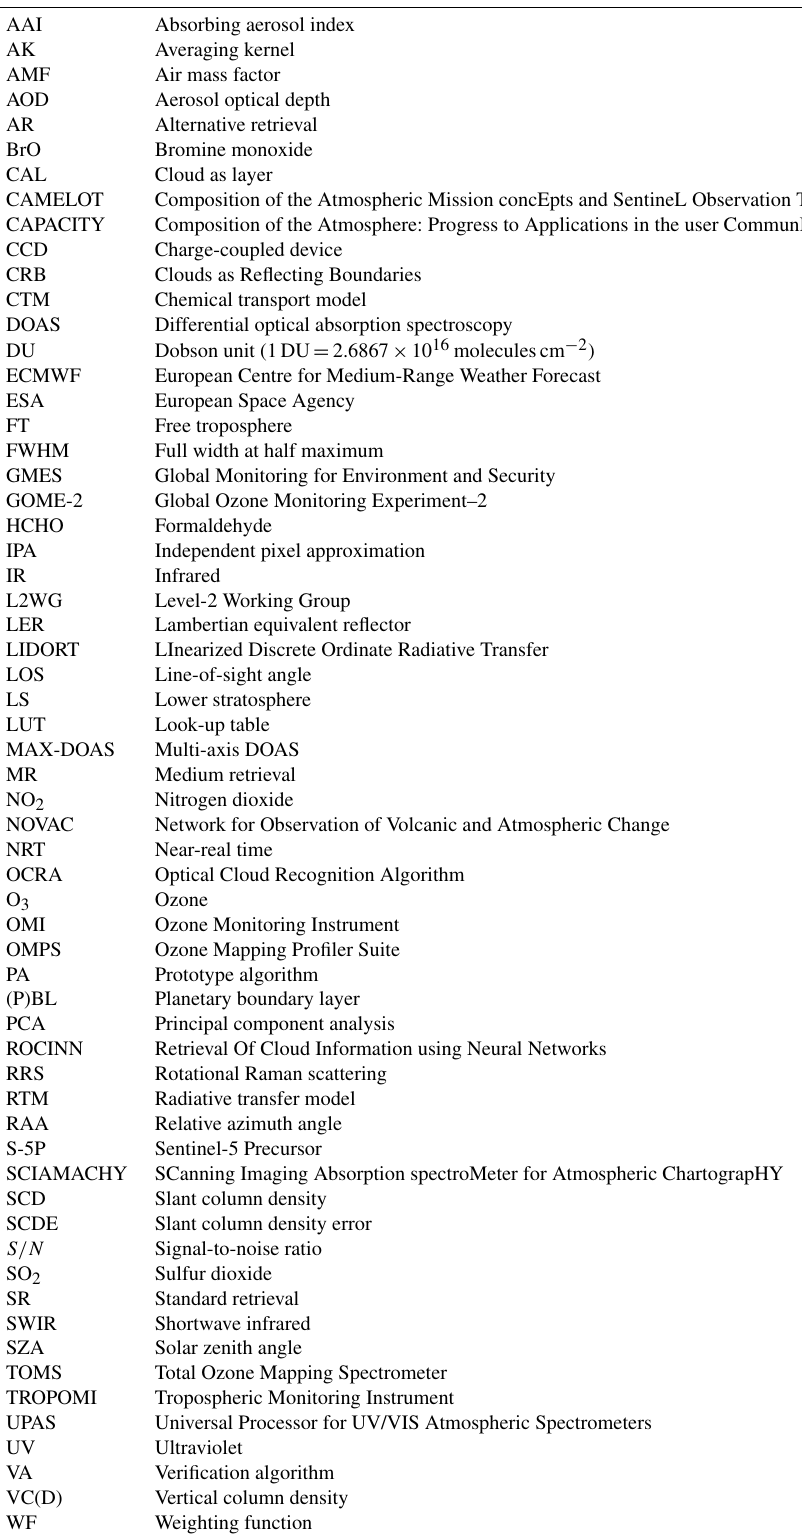
Table A4. Acronyms and abbreviations.